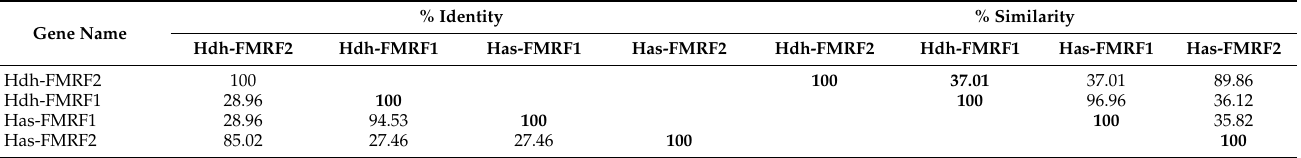
Table 1. Amino acid percent identity and percent similarity among FMRF1 and FMRF2 amino acid sequences of H. discus hannai and H. asinina